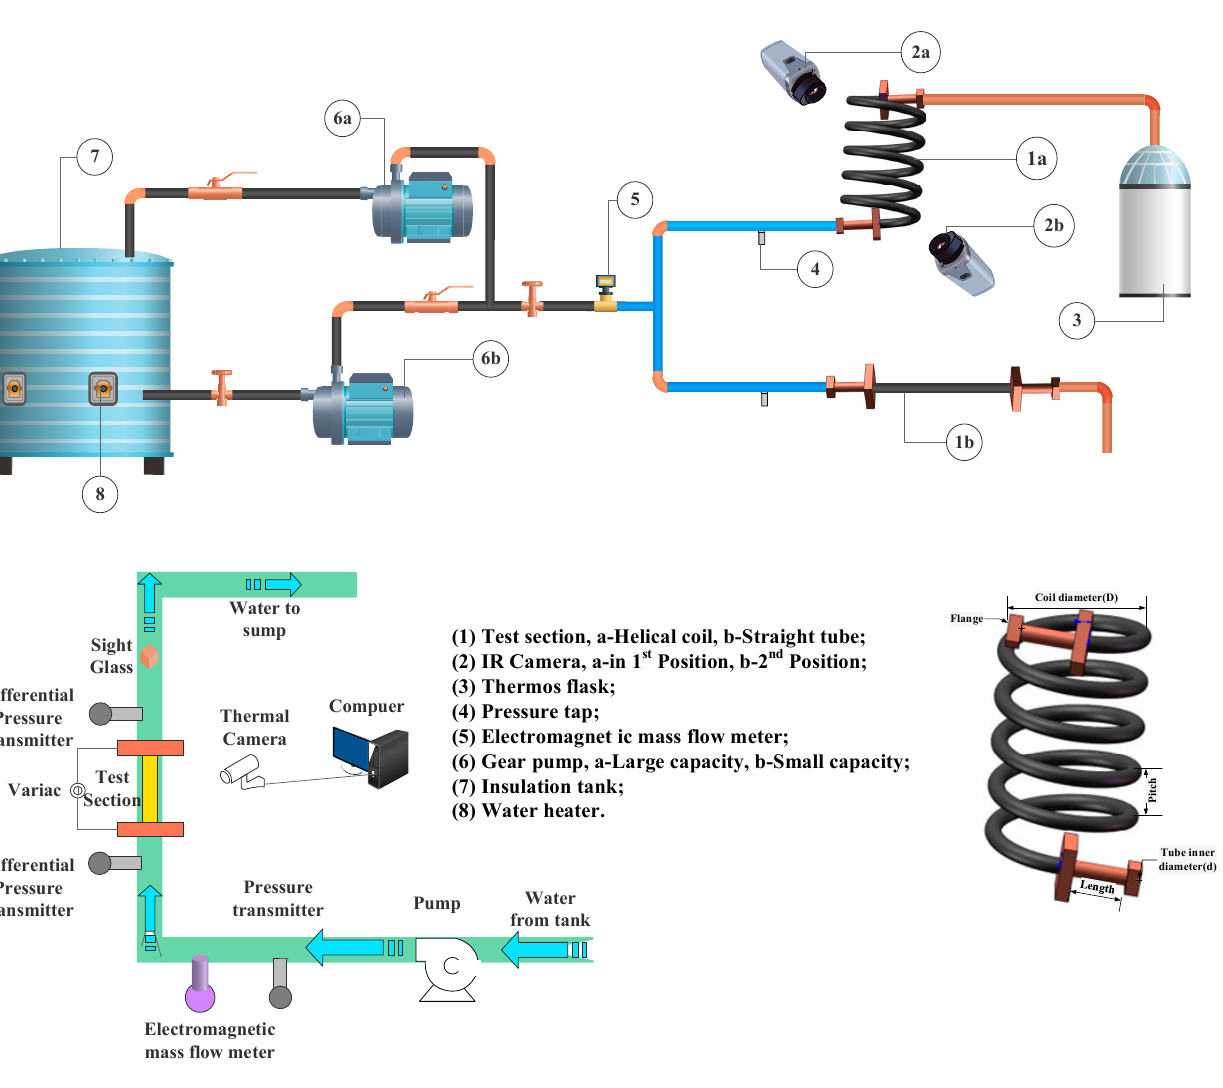
Figure 4. Schematic diagram of the experimental test rig with infrared thermal imaging technique [58].